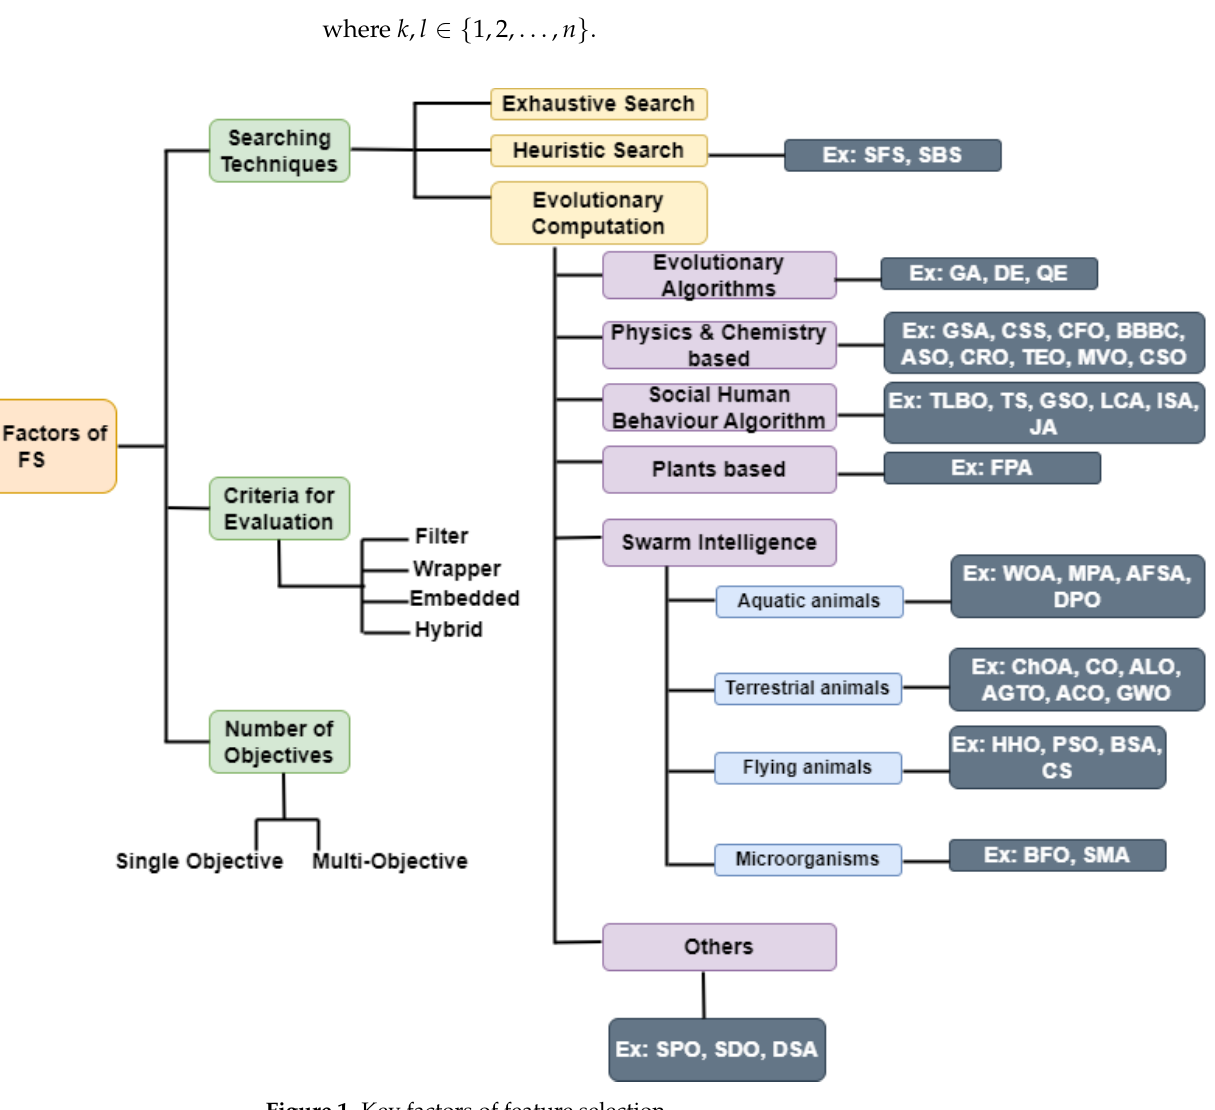
Figure 1. Key factors of feature